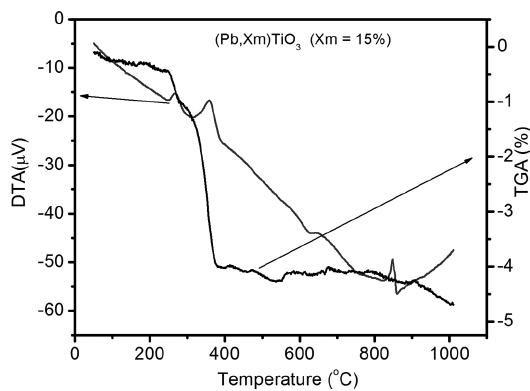
Figure 1. Differential (DTA) and thermogravimetric (TGA) analysis of the PXT10 powders mixture.